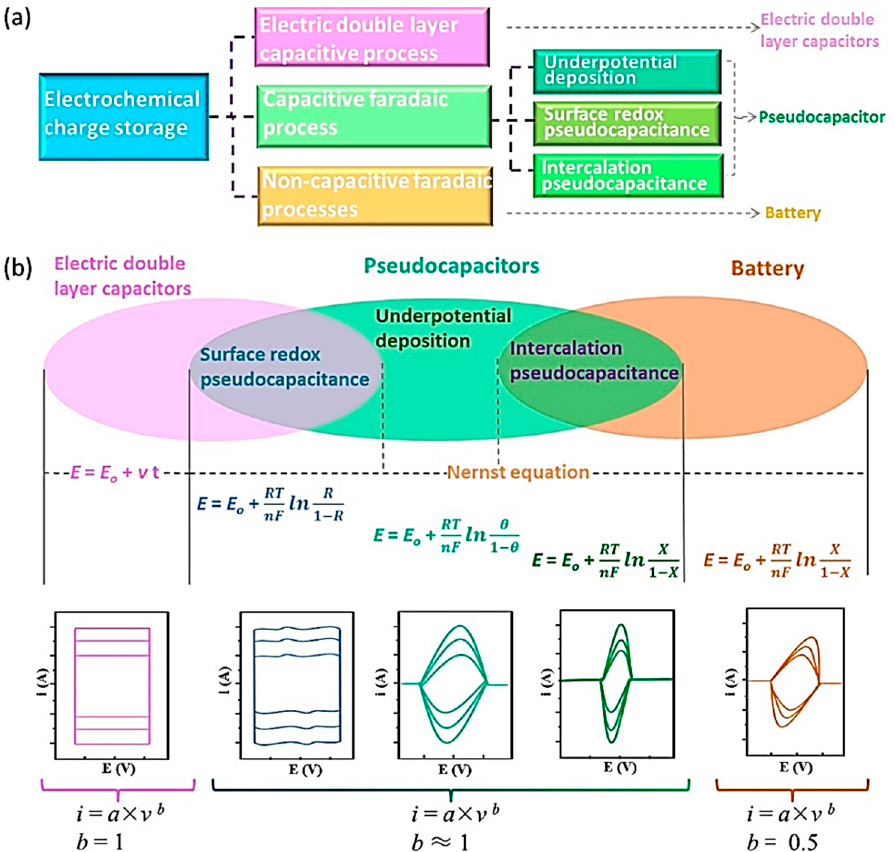
Figure 4. ( a ) Different types of electrochemical charge storage processes. ( b ) Schematic illustration of correlations and differences among these electrochemical processes. Reprinted with permission from Ref. [52] Copyright 2019 Elsevier.